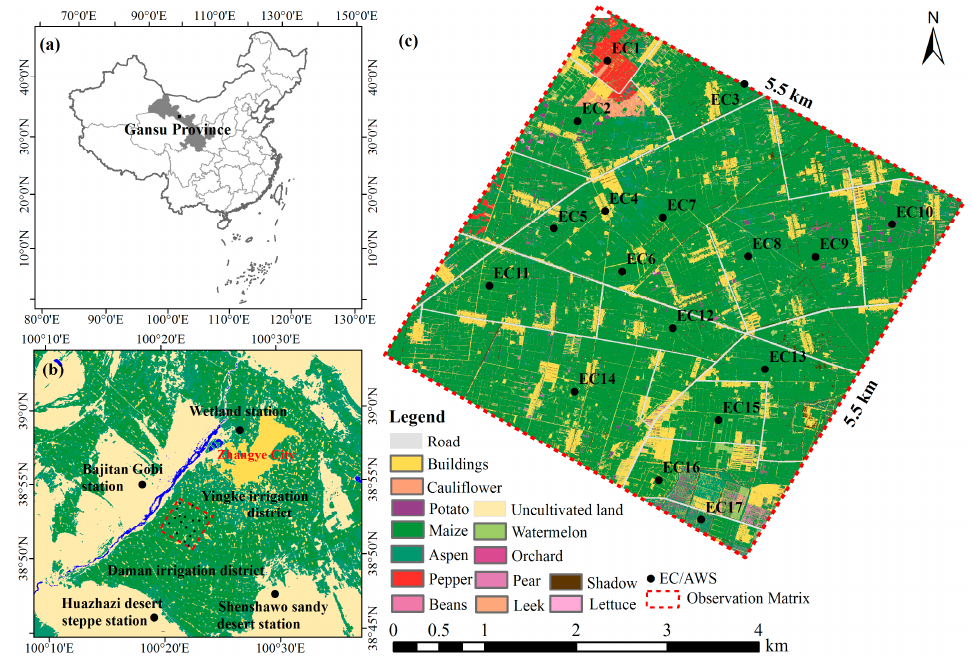
Figure 1. Geographical information of the study area: ( a ) schematic of Zhangye city and middle Heihe River Basin; ( b ) locations of HiWATER-MUSOEXE observation matrix; ( c ) detailed locations of the 17 EC systems and AWSs inside the Zhangye oasis. EC/AWS is the abbreviation for eddy covariance/automatic weather station.